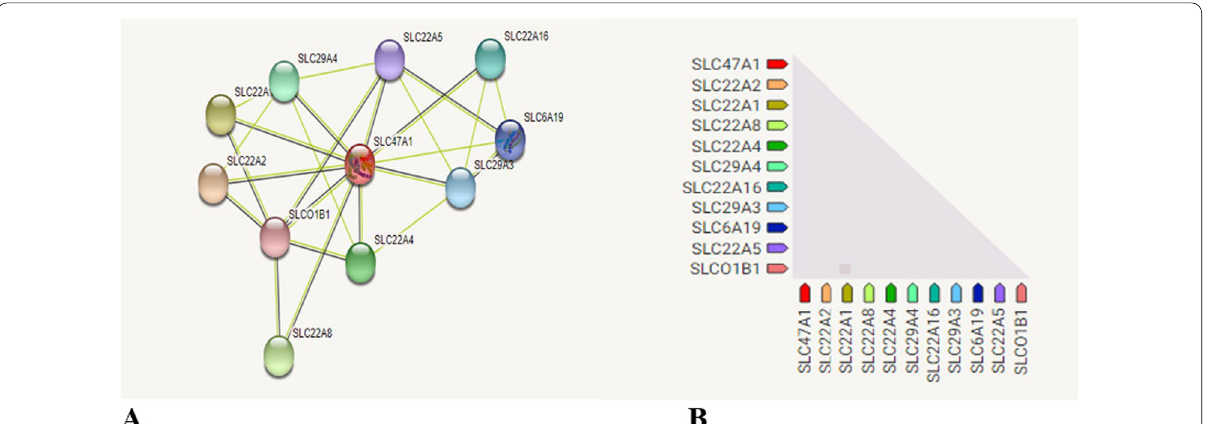
Fig. 3 a MATE1 protein–protein interactions with its partners b Coexpression pattern of the genes which correlates with the gene encodes MATE1